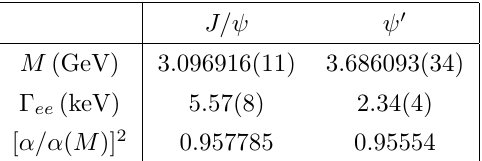
Table 5 . Masses and electronic widths [47] of the narrow charmonium resonances and e(cid:11)ective electromagnetic coupling [48]. (cid:11) = 1 = 137 : 035999084(51) is the (cid:12)ne structure constant, while (cid:11) ( M ) stands for the pole-subtracted e(cid:11)ective electromagnetic coupling at the scale M